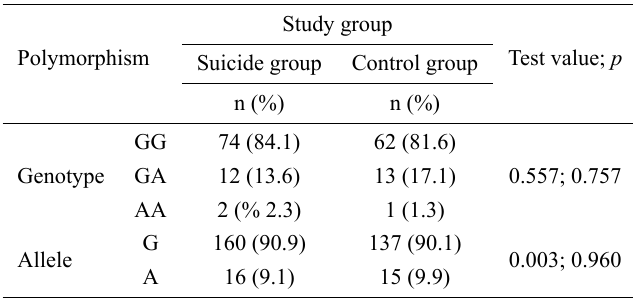
Table 9. Comparison of the study groups in terms of TPH-2 gene rs1386494 polymorphism.